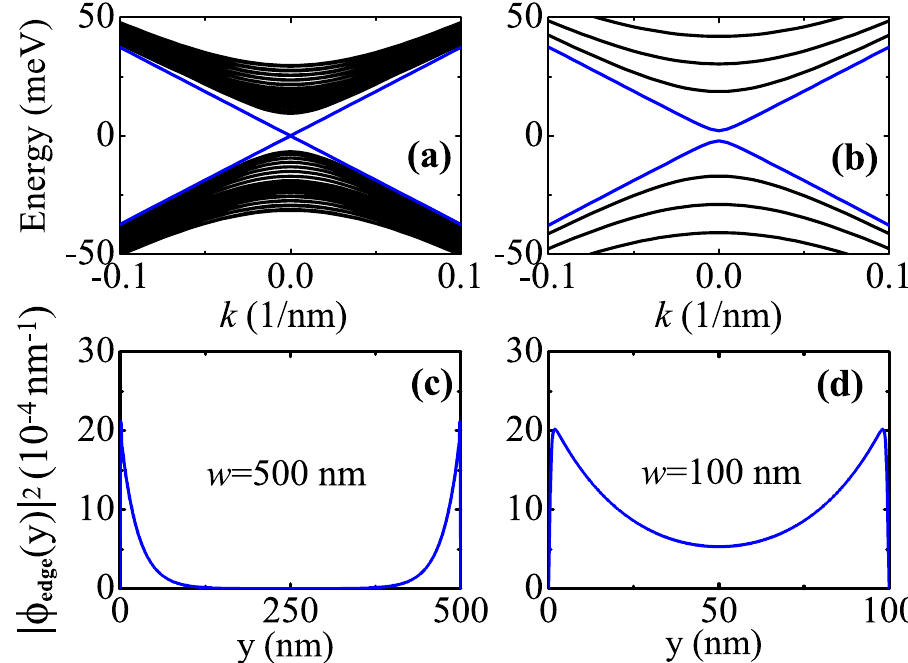
Figure 5. Energy spectra and edge-state wave functions at k = 0 for different ribbon widths: ( a ) and ( c ) plot the results for w = 400 nm; ( b ) and ( d ) plot the results for w = 100 nm. Here, the red dashed and solid lines in ( a ) and ( b ) represent the bulk band-edge and edge band-edge, respectively. The temperature and QW thickness are fixed at T = 100 K and d = 9 nm.